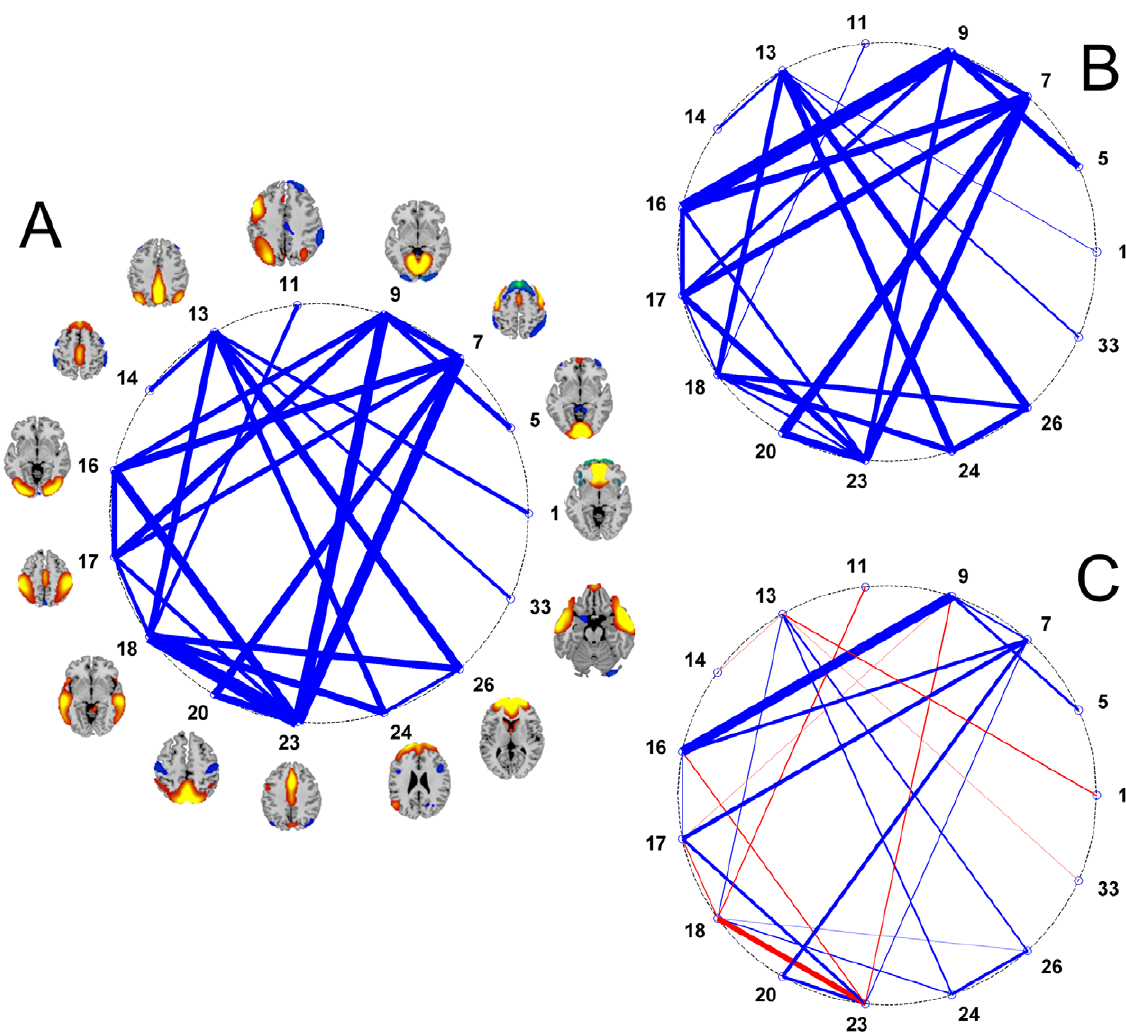
Figure 3. The functional network connectivity between 15 spatially independent task-related components. A) The lines represent the between age group t -values of functional network connectivity. The mean functional network connectivity for the young B) and old C) age groups is presented for descriptive purposes showing the functional network connections that significantly differ between age groups. The placement of the nodes around the circles is related to the order in which the components were extracted with ICA. Therefore, the placement is arbitrary and the reader should not make any inference on the length of the edges in the graphs, only on the fact that the functional network connections are for the most part stronger in the young than the elder age